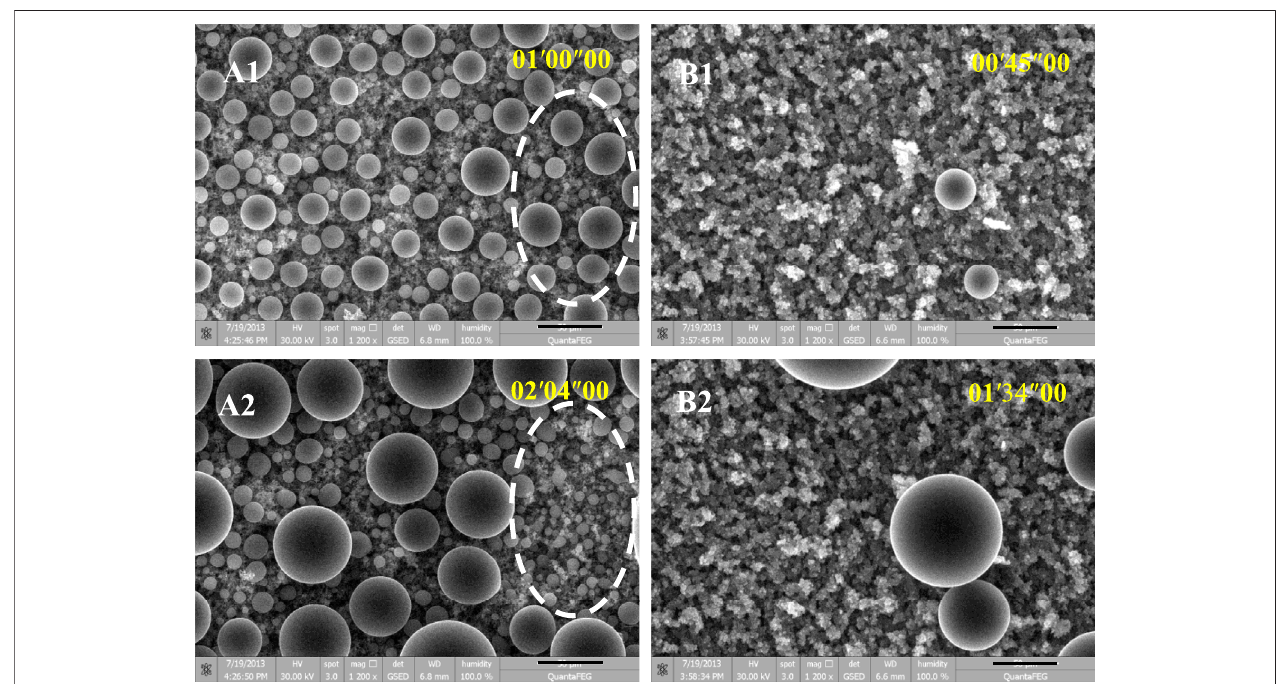
FIGURE 3 | Time-lapse ESEM images of vapor condensation on SHSs with submicron rectangle structures (A1-2) and with coral-like micro/nano-structures (B1- 2), respectively. The scale bar is 50 μ m. The temperature of the sample stage was fi xed at ~1 ° C. The vapor pressure was gradually increased to ~800 Pa, at which the vapor started to nucleate on the sample surface, and then maintained at ~800 Pa during imaging. The images were taken every 1.6 s. The time scale in the images is minute, second, and millisecond.